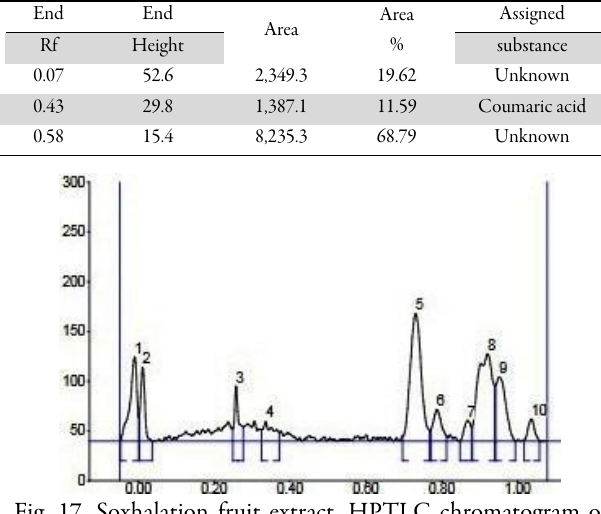
Fig. 17. Soxhalation fruit extract, HPTLC chromatogram of hexane fruit extract of M. cymbalaria